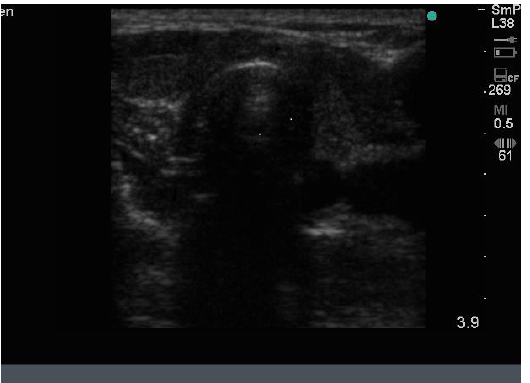
Figure 17. Thyroid ultrasound from a patient with sub-acute thyroiditis. The impressive looking black streaks seen in the acute phase rapidly disappear as the gland recovers and the texture returns to normal.